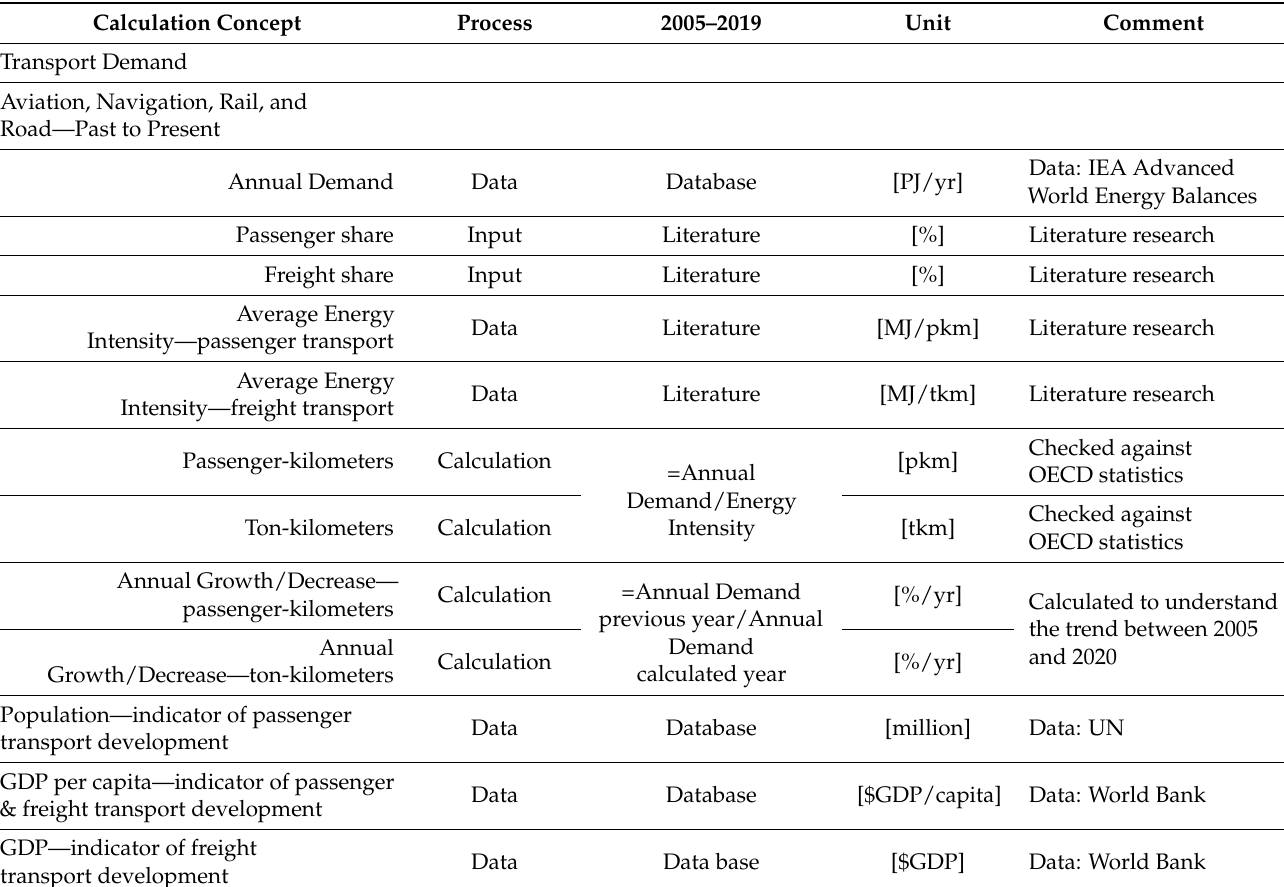
Table 2. Calibration for calculating the transport